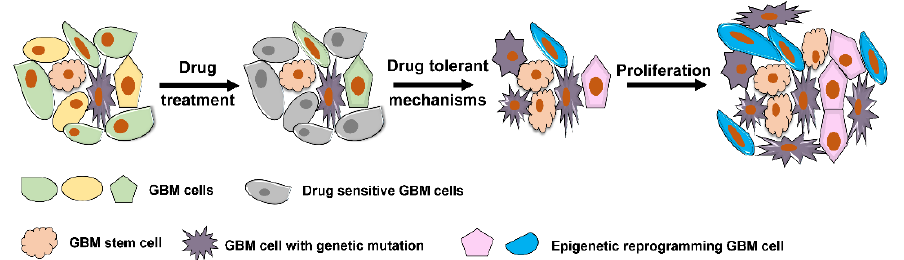
Figure 2. Representative mechanism underlying drug resistance in GBM. GBM cells that carry resistance-conferring mutation(s) in a heterogeneous cancer population and GBM stem cells that are intrinsically resistant to drug treatment survive drug exposure and outgrow to determine the further cancer population. A group of GBM cells evolved through epigenetic reprogramming become drug-tolerant cells and further confer resistance to drug therapy.